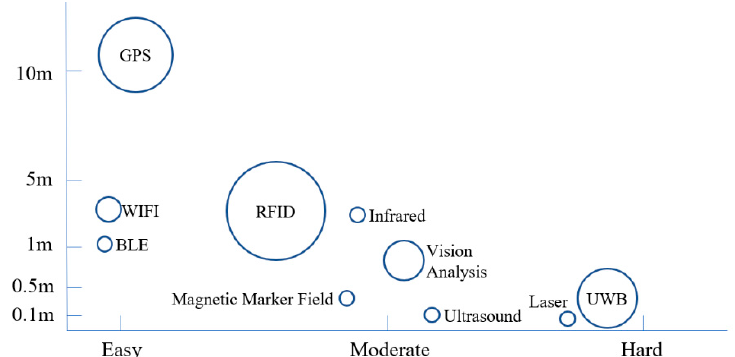
Figure 3. Comparison of major RTLS technologies (where the circle size reflects how widely the technology has been adopted).